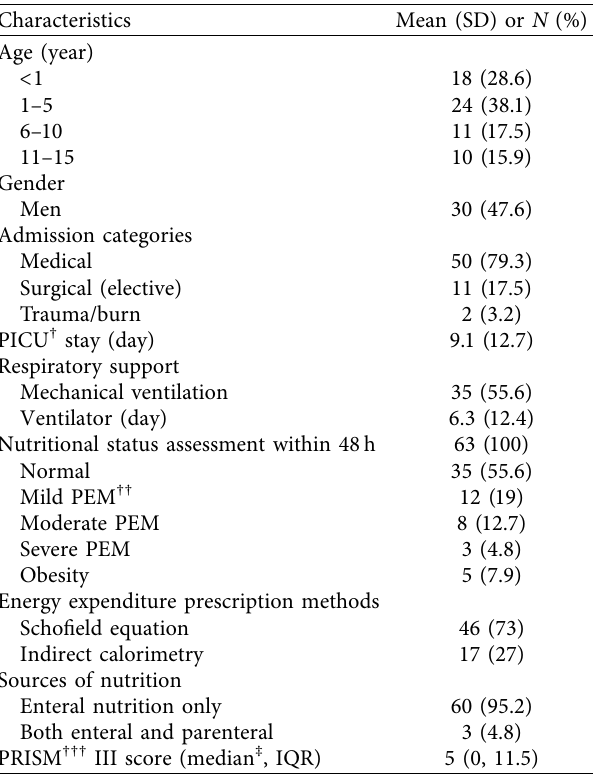
Table 1: Patient’s characteristics of participating critically ill children ( N � 63).